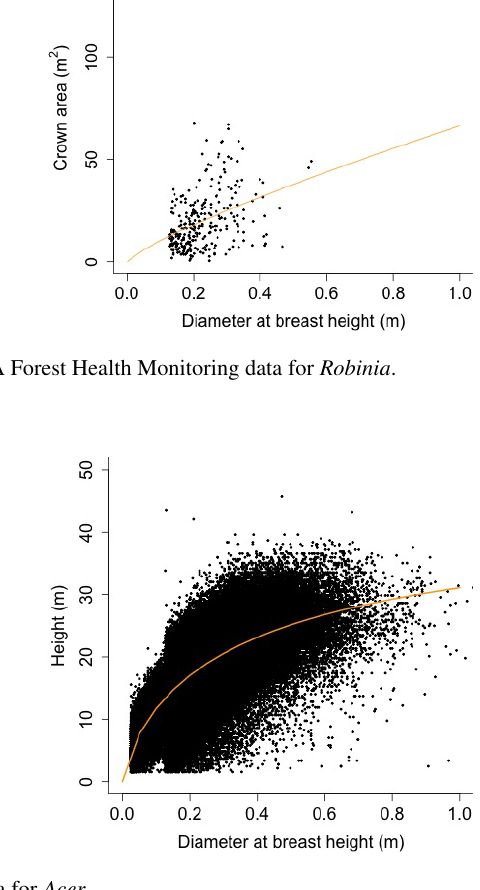
Figure D12. Height model fit to FIA data for Acer .